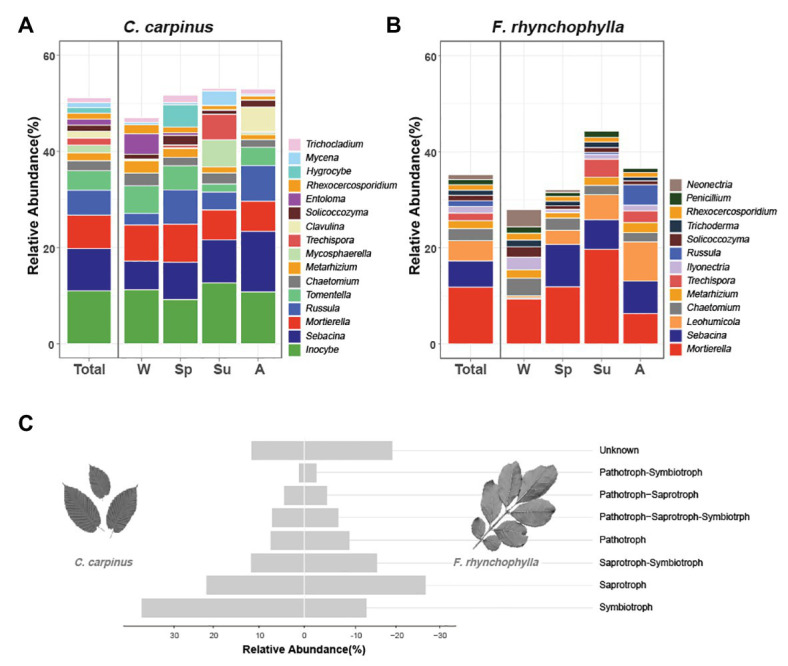
Taxonomic distribution of soil fungal communities in Carpinus cordata and Fraxinus rhynchophylla forests. The average relative abundances of genera in soil fungal communities of (A)
C. cordata and (B)
F. rhynchophylla forests are represented according to seasonal change. The genera with relative abundances less than 1% are not shown. (C) Average relative abundance of taxa belonging to each trophic mode in fungal communities of C. cordata and F. rhynchophylla forests. Unknown = taxonomic groups with unassigned trophic modes.